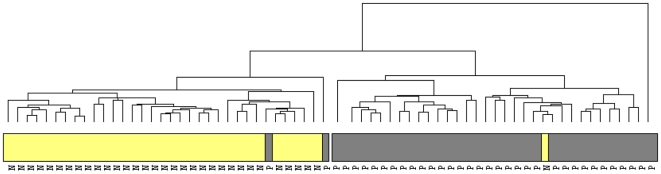
Dendrogram of sample relatedness.A dendrogram of sample relatedness from the cluster analysis shown in Figure 1 using the statistically significant differentially expressed genes. Samples clustered into main groups, aligning well with classification of PC or HC. PC PBMC samples are indicated by grey bars while healthy PBMC samples are denoted by yellow bars.